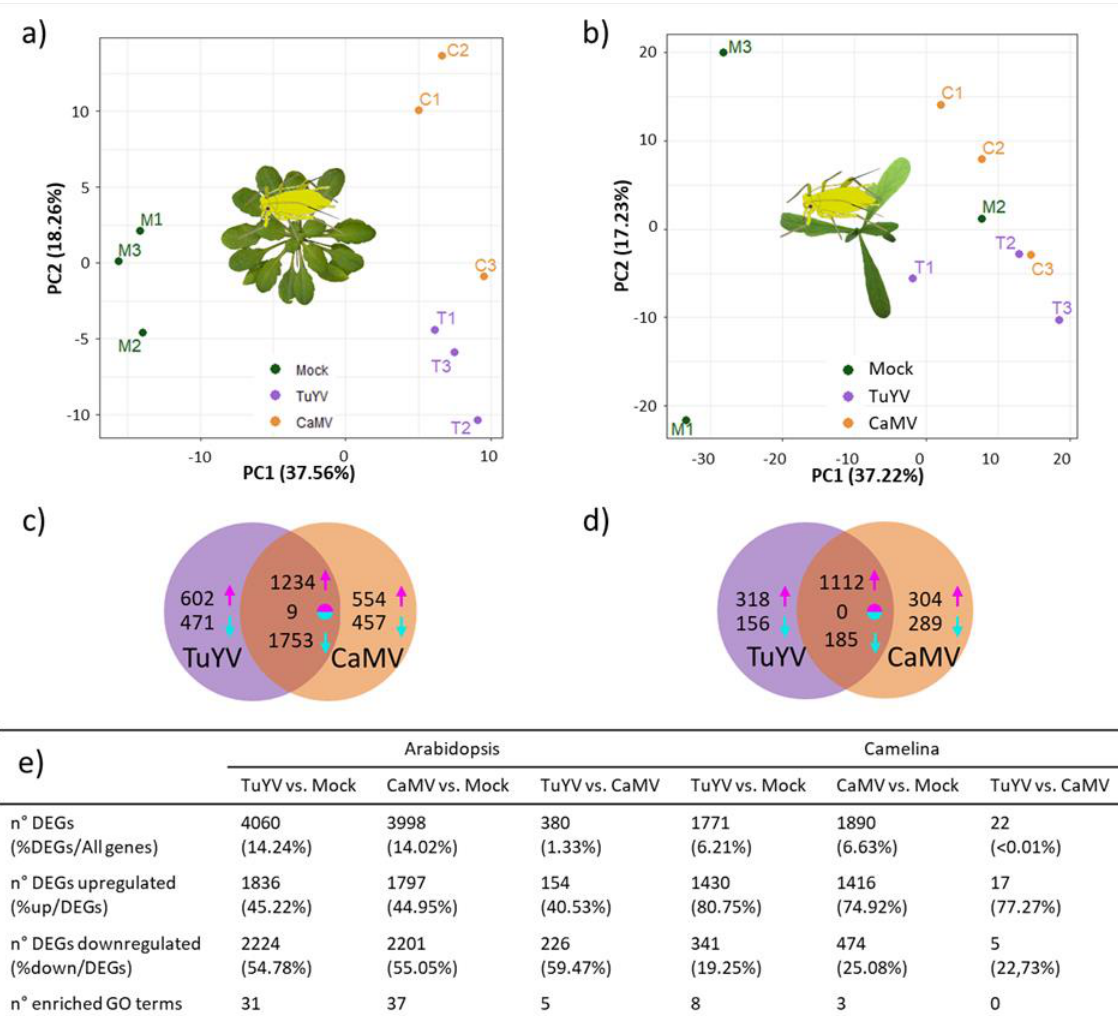
Figure 1. Analysis of the transcriptome profiles of aphids fed on mock-inoculated vs TuYV- and CaMV- infected plants. (a-b) Principal component analysis of three biological replicates for each condition of Myzus persicae feeding on (a) Arabidopsis thaliana and (b) Camelina sativa . The dots of the same color correspond to the biological replicates for each condition. The mock 2 (M2) Camelina sample was excluded from the analysis because it did not cluster with the other two replicates. (c-d) Venn diagrams presenting the number of differentially expressed genes (DEGs) in aphids fed on TuYV- and CaMV- infected Arabidopsis (c) and Camelina (d), compared to respective mock-inoculated controls. Magenta arrows: number of up-regulated genes, cyan arrows: number of down-regulated genes and two-color circles: inversely regulated genes (up-regulated genes in one virus-infected modality and down-regulated in the other virus-infected modality). e) The number of DEGs and enriched GO categories in aphids fed on TuYV and CaMV-infected plants vs mock controls as well as on TuYV- vs CaMV-infected